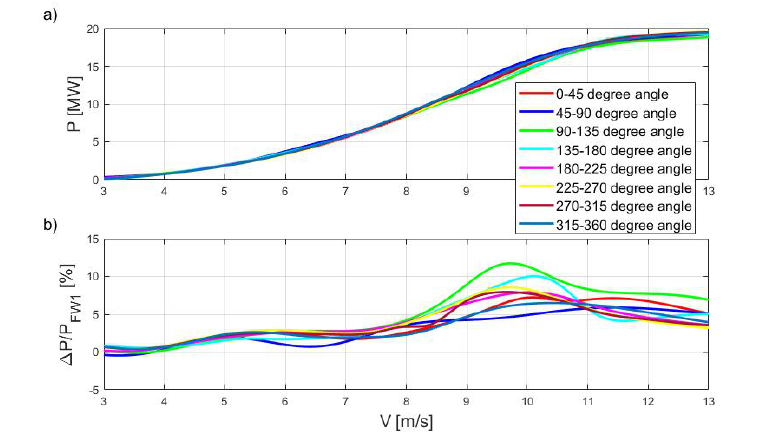
Figure 12. Wind power plant FW1: ( a ) FW1 power characteristic for wind directions in ranges of 45 degrees, ( b ) generated power difference for selected wind directions as percent of the farm’s rated power.